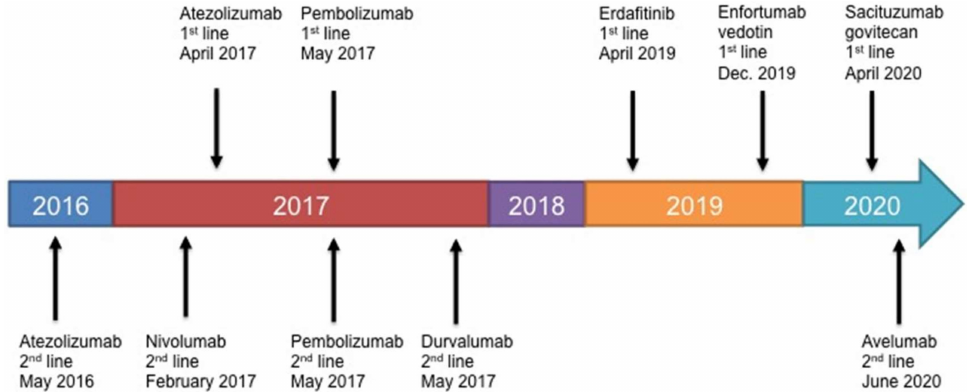
Figure 1. FDA approval timeline for ICIs, EV, and Erdafitinib against bladder